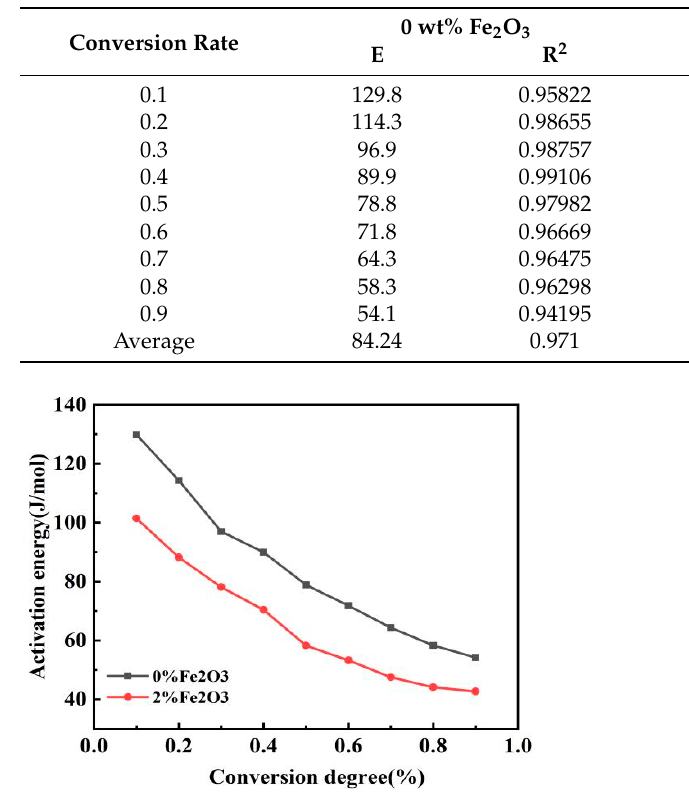
Figure 7. Fitting curves of activation energy ( a ) without and ( b ) with catalyst. Curve fitted by FWO method in the ( a ) absence and ( b ) presence of the catalyst. Table 5. Link between activation energy and percentage conversion.